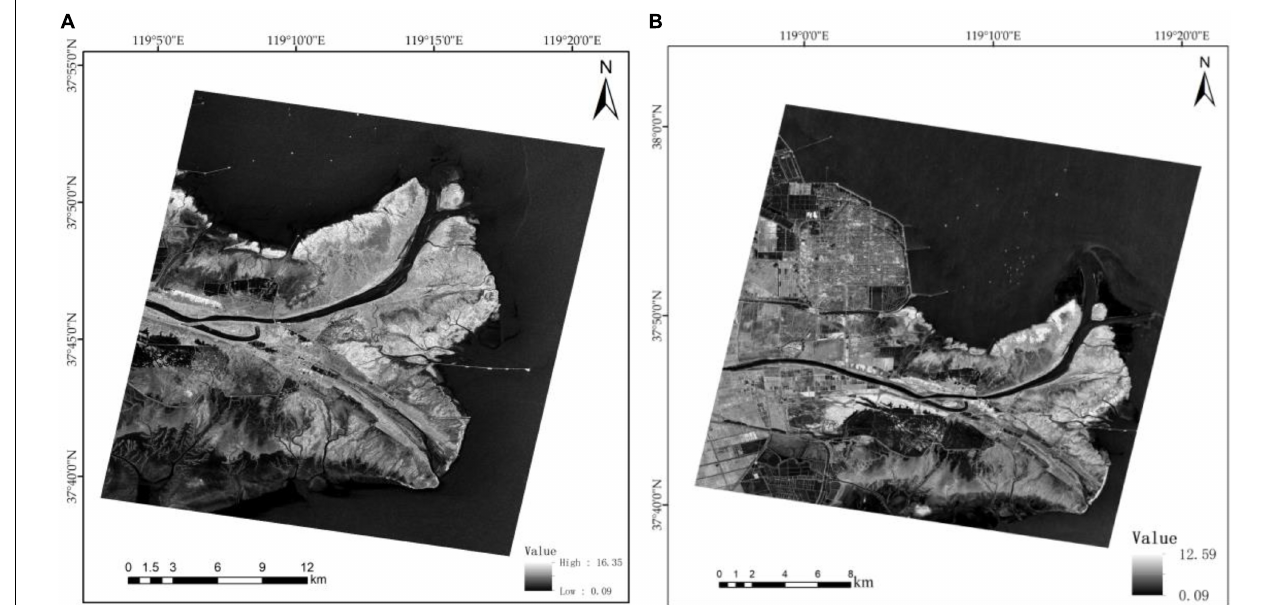
FIGURE 6 | The polarimetric total power of GF-3. The dark area is water body, and the brighter area is various vegetations in the figure. (A) Is the data of October 2017, (B) is the data of November 2018.